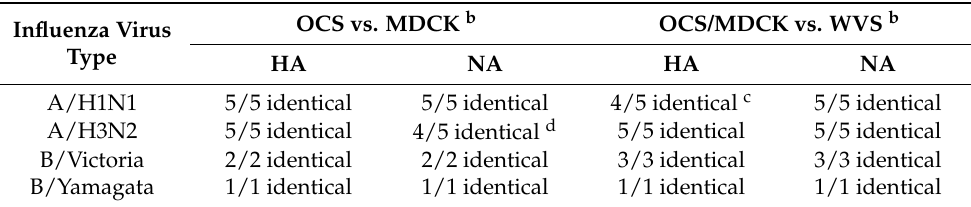
Table 1. Comparison of sequence data for HA and NA isolated from virus samples obtained at different stages in the manufacturing process [38] a